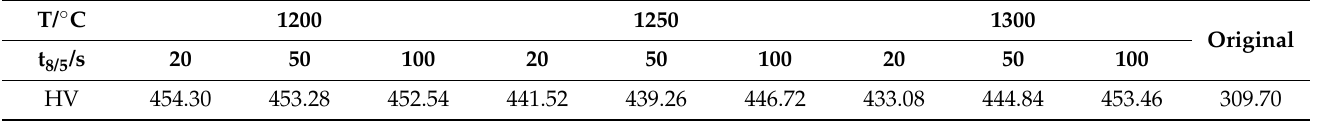
Figure 14. Vickers hardness at different peak temperatures and t 8/5 time. Table 3. Average Vickers hardness values at different peak temperatures and t 8/5 time.